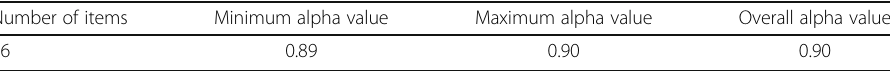
Table 11 Reliability test